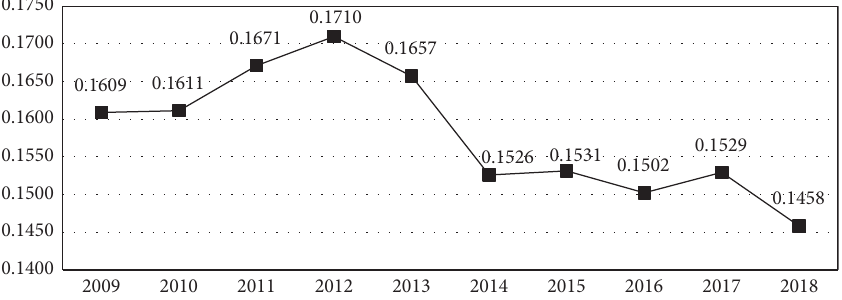
Figure 3: Average market power of 37 construction companies from 2008 to 2018.